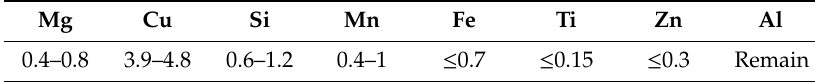
Table 1. Chemical composition of LD10 (mass fraction %).